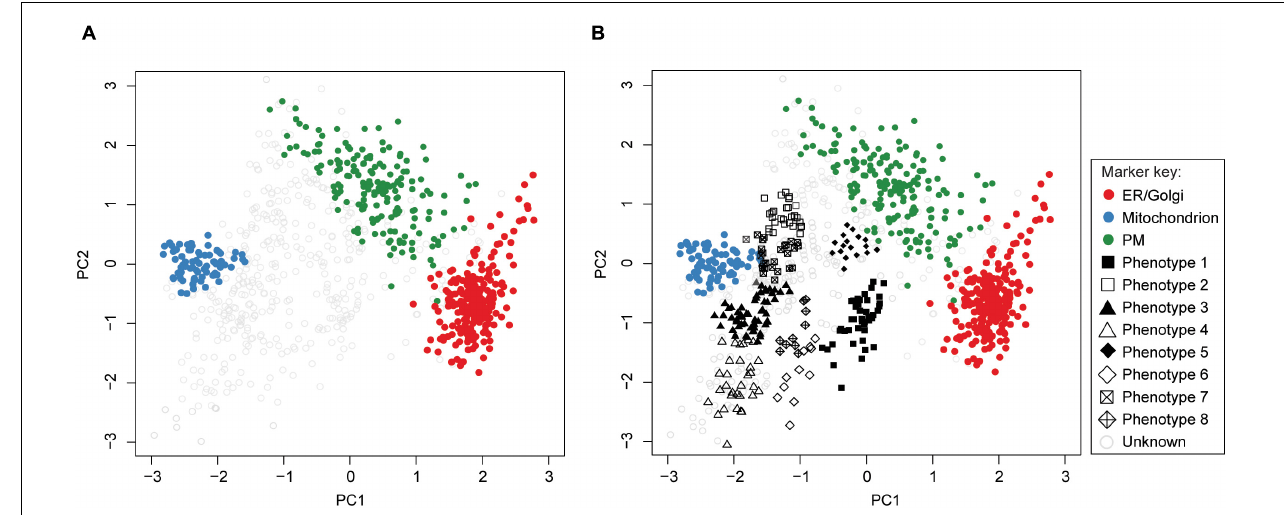
FIGURE 8 | PhenoDisco algorithm helps assign localizations to proteins. First, the algorithm uses a minimal set of markers and unlabeled data as input to detect new phenotypes (i.e., clusters) via unsupervised learning. These are then used in supervised learning to predict protein localizations. (A) Drosophila melanogaster data (Tan et al., 2009) and ER/Golgi, Mitochondrion, and PM markers were used as input (ER, endoplasmic reticulum; PM, plasma membrane). (B) The phenotypes we identified by using phenoDisco correspond to ribosomal subunits (phenotypes 1 and 3), proteasome (phenotype 2), nucleus (phenotype 4), peroxisome (phenotype 6), and proteins with uncertain localization (phenotypes 5, 7,